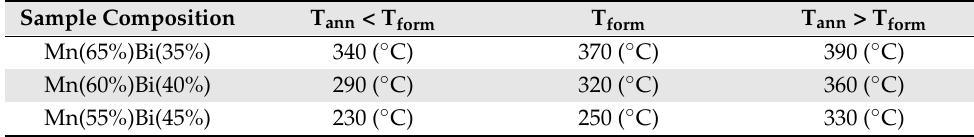
Table 2. Annealing temperatures for the assorted films.